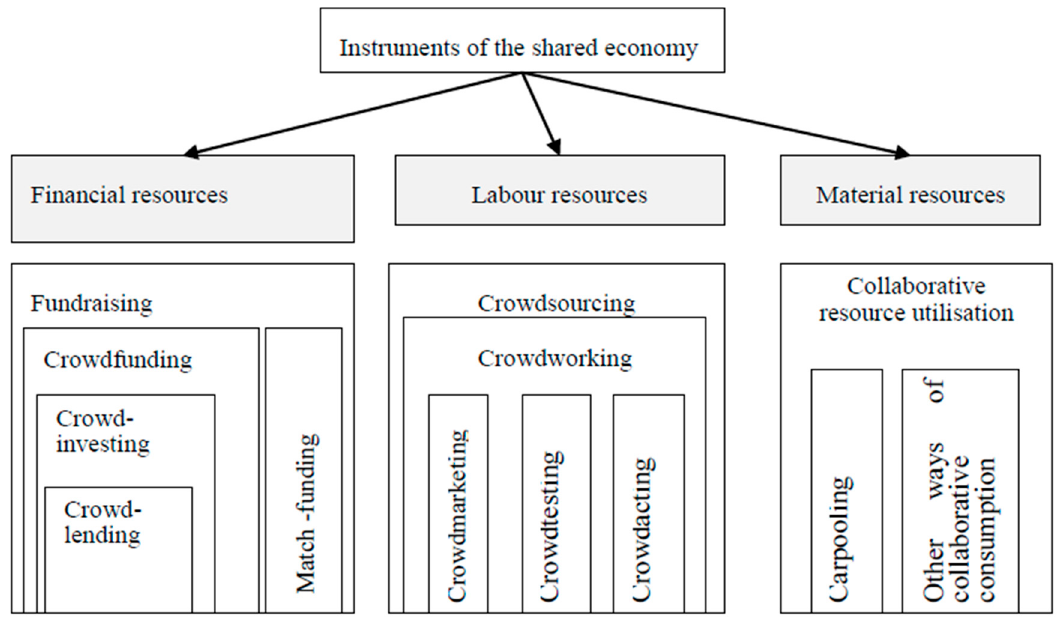
Figure 1. The structure of instruments of the shared economy.